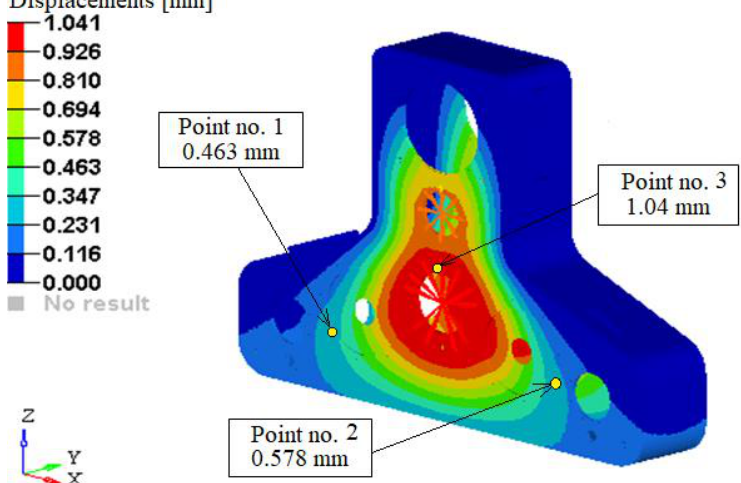
Figure 10. Distribution of the displacements on the front surface of the housing.